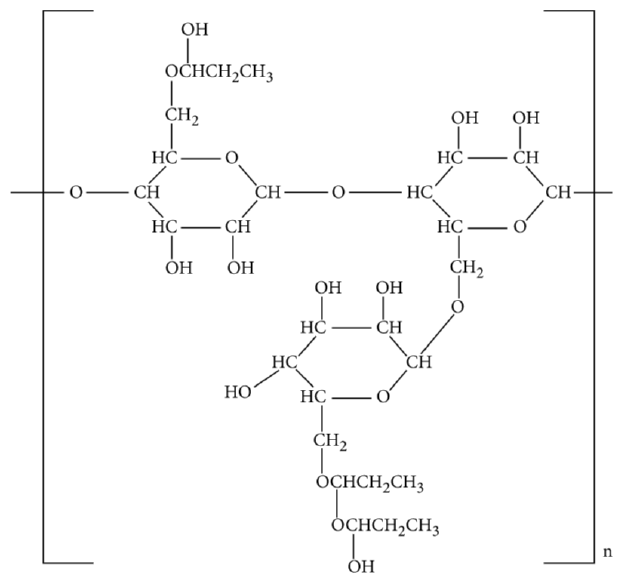
Figure 3. Molecular structure of HPG [41].